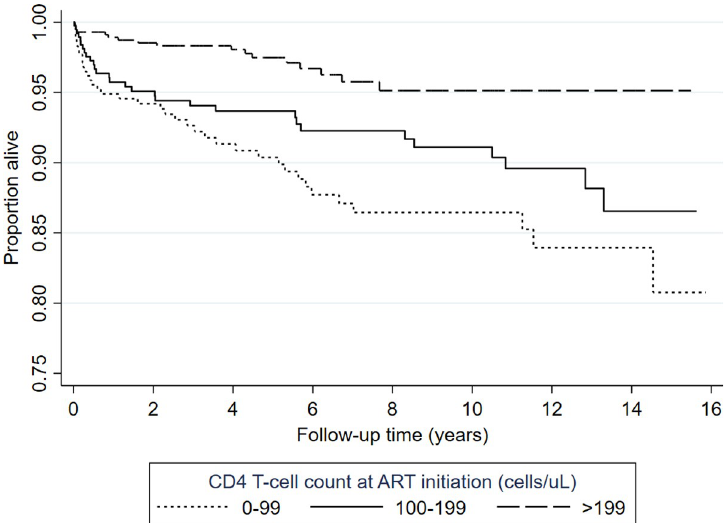
Fig 3. Kaplan-Meier curve showing survivor estimates by baseline CD4 T-cell categories adjusted for sex, employment, and marital status. Increasing baseline CD4 T-cell counts were associated with lower likelihood of failing ART (p = 0.017), whereas being male, unemployed, or unmarried were not associated with failing ART. Among patients still in care, the number of patients with unsuppressed viral loads was too low to assess for association between independent risk factors of death and having unsuppressed viral